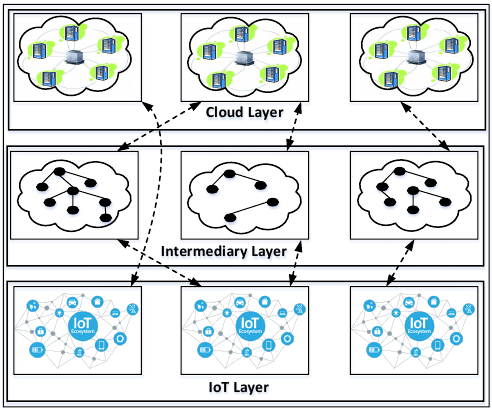
Figure 1. The relationship chain between different computing paradigms.